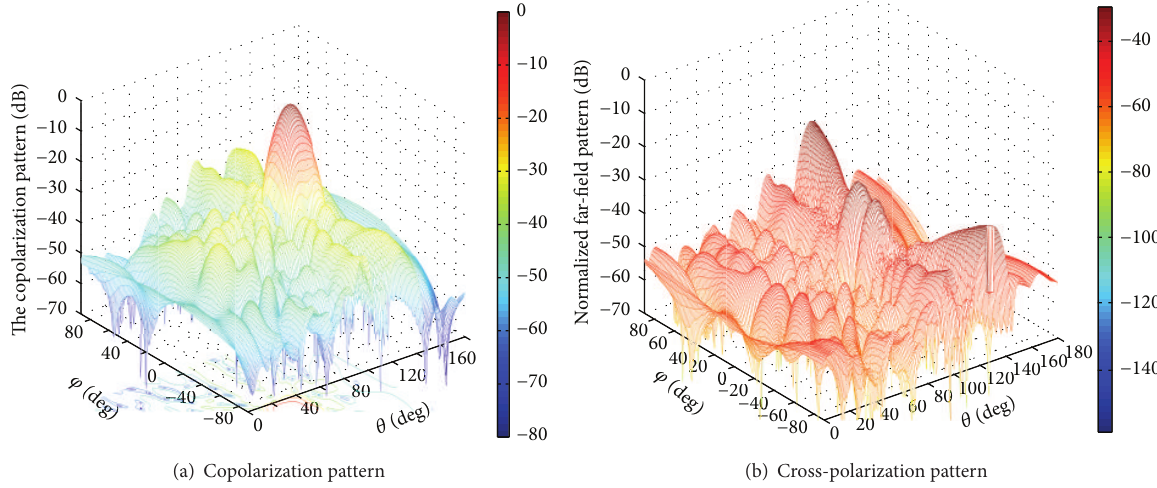
Figure 15: 3D radiation pattern of the conical conformal array for scan direction of (105 ∘ , 0 ∘ ) for solution A in Figure